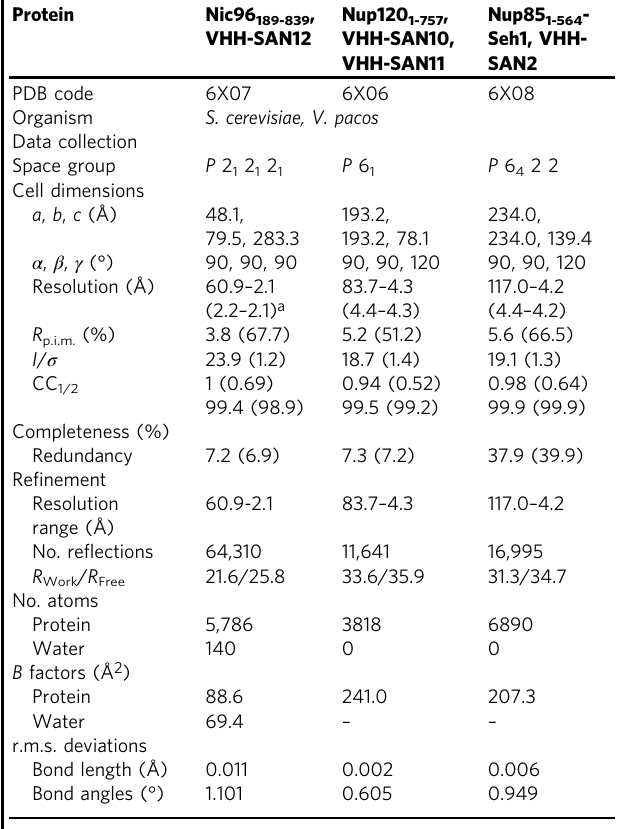
Table 2 Data collection and re fi nement